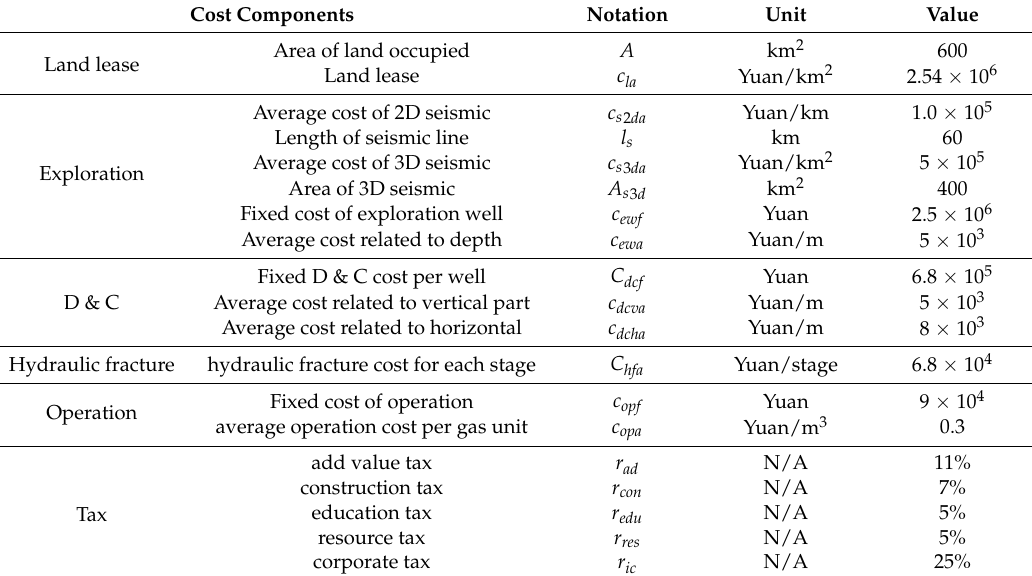
Table 2. Key factors for cost component calculation in the Fuling